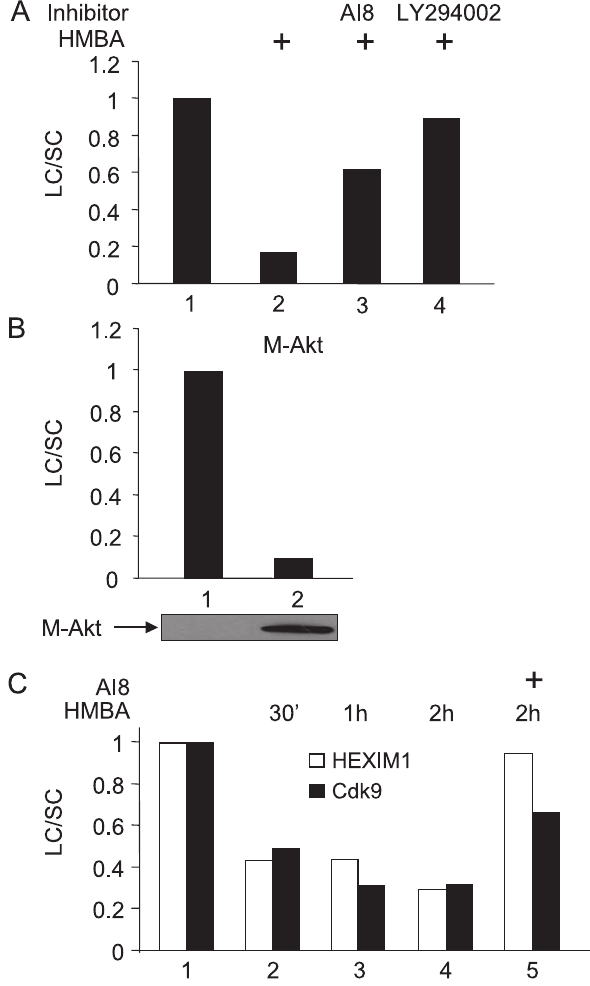
Figure 3. HMBA Disrupts the LC via the PI3K/Akt Pathway Jurkat cells were stimulated or not with HMBA (5 mM) for 1 h in the presence or absence of LY294002 (10 l M) or AI8 (1 l M) in (A) or were electroporated with the empty plasmid vector or a vector expressing M- Akt for 24 h in (B). Total cell lysates were then subjected to glycerol gradient sedimentation and fractions were analyzed as in Figure 1. Western blotting was performed using anti-HEXIM1 antibodies. Results present the ratio LC/SC as in Figure 1. In (C), a similar analysis was performed using total cell lysates of non-adherent PBMCs pre-treated or not with AI8 and stimulated or not with HMBA (5 mM) for 30 min, 1 h, and 2 h.